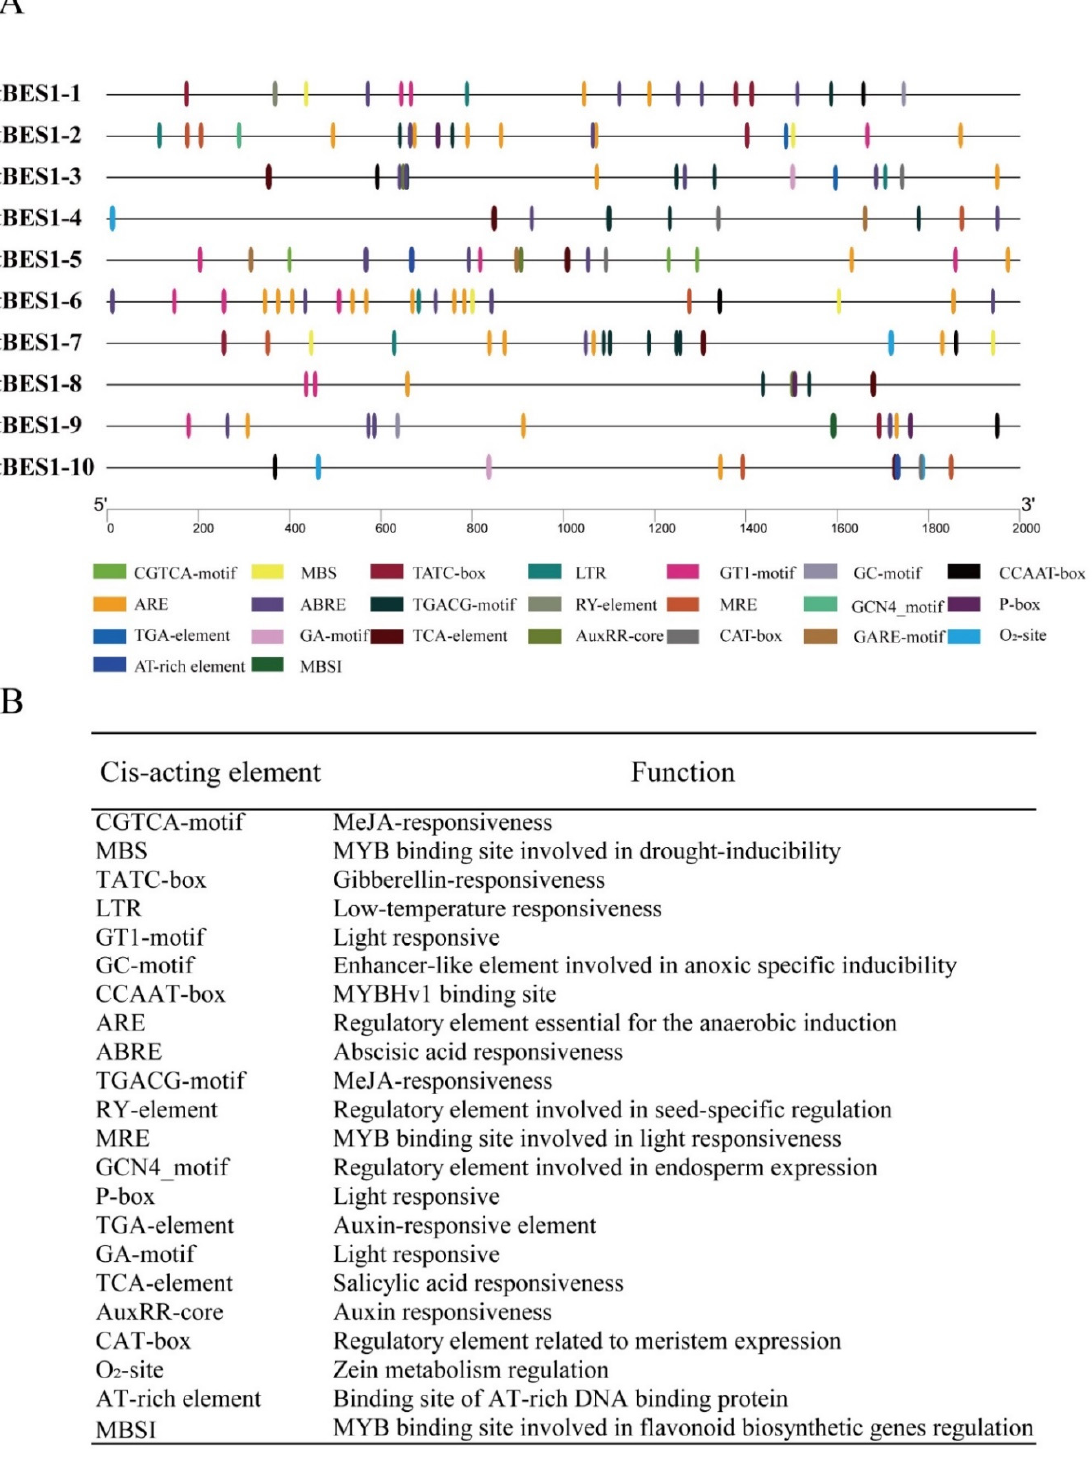
Figure 3. ( A ) Analysis of cis-acting elements of FtBES1 gene promoter; different colors indicate different elements. ( B ) List of functions for each cis-element.